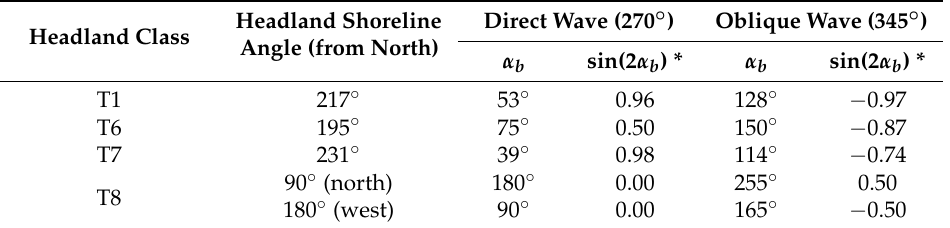
Table 11. Incident waves on northern faces of headlands by wave